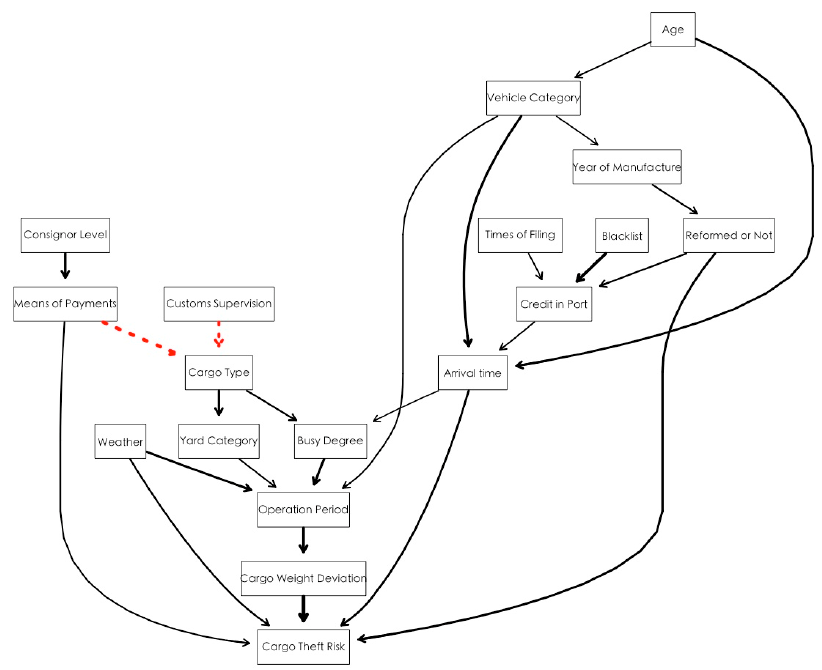
Figure A1. The Bayesian network structure derived using combinations of heuristic structure search algorithm with HC and score function with Aic.